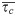
Average commuting time τc¯ measured for different cities versus the predicted value of our model (Eq 18).We perform the fit on the single parameter g using Eq 18, leading to an average value g ≈ 0.203 (the Pearson correlation is here 0.65). The existence of large fluctuations around our prediction is probably connected to the spatial organization of the city and the structure of the transportation networks.